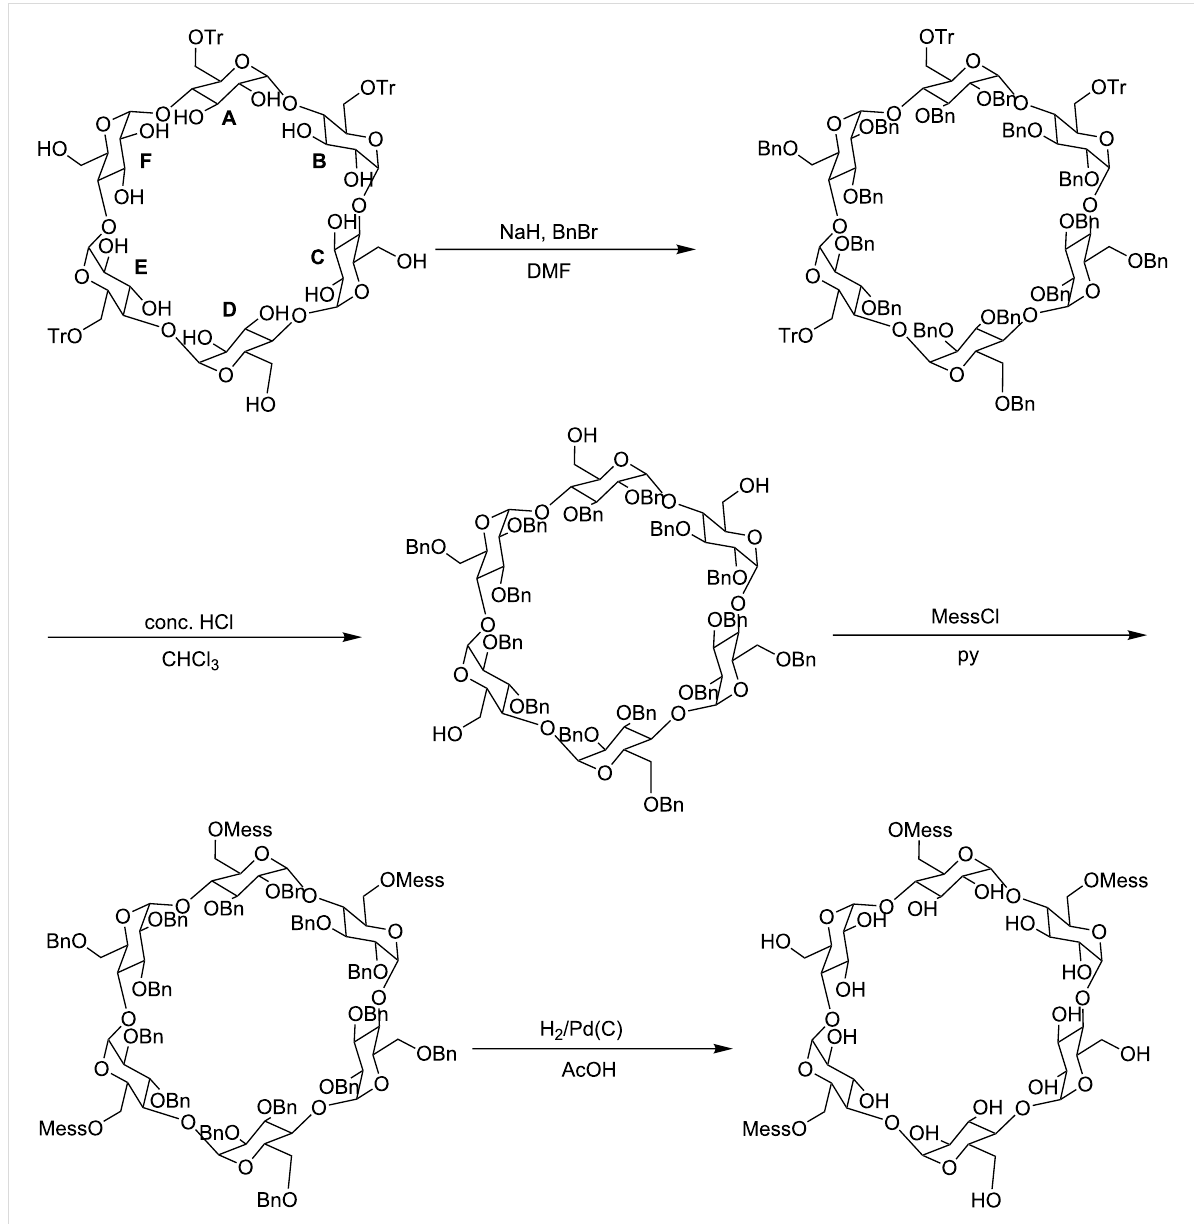
Scheme 2: A pathway of the conversion of a regioisomer of tri-6- O -trityl- α -CD (ABE isomer) to the corresponding tri-6- O -mesitylenesulfonyl- α -CD. Letters A to F represent the glucopyranose units, numbered in a clockwise direction when viewed from the secondary hydroxy group side. Abbrevia- tions: Tr: trityl, Bn: benzyl, and Mess: mesitylenesulfonyl.